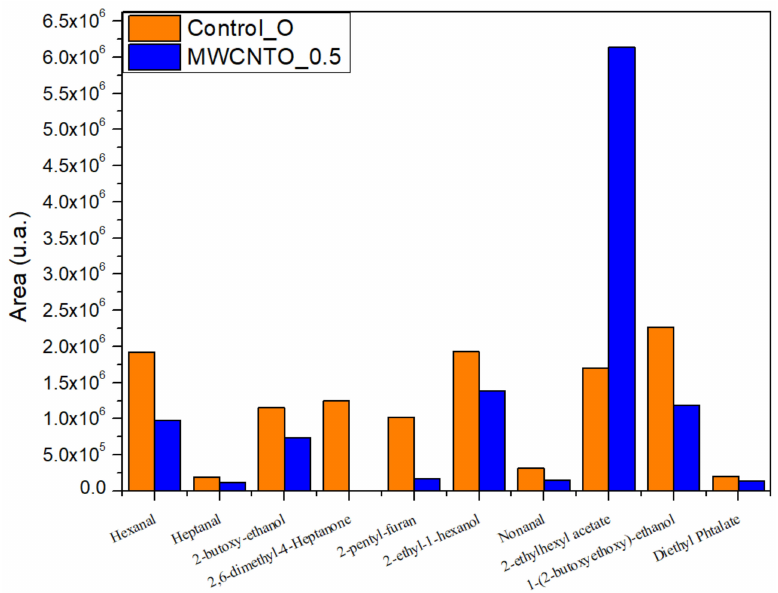
Figure 8. VOCs released by the sheepskin treated leathers compared with the control